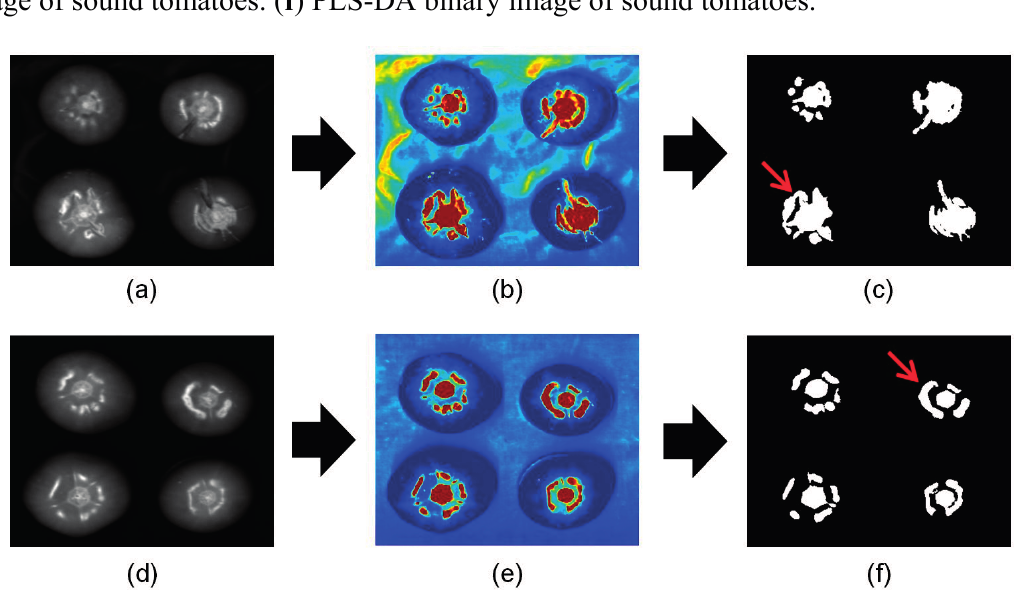
Figure 4. Imaging processing procedures by a PLS-DA model that could discriminate between crack and sound areas on tomatoes. ( a ) Single waveband image of a cracked tomatoes (1098 nm). ( b ) PLS-DA image of cracked tomatoes. ( c ) PLS-DA binary image of cracked tomatoes. ( d ) Single waveband image of sound tomatoes (1098 nm). ( e ) PLS-DA image of sound tomatoes. ( f ) PLS-DA binary image of sound